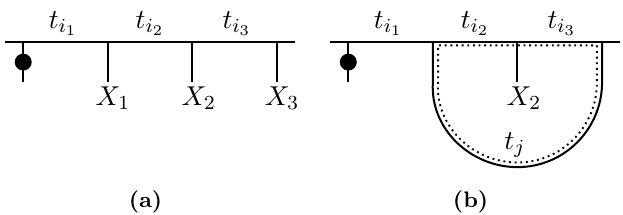
Figure 21. To prove eq. (5.3) inductively for diagrams belonging to a certain class, we can show that the measures [d m 0 ] n +2 and [d m 0 ] n for the diagrams in (cid:12)gure 21a and (cid:12)gure 21b have the ‘ ‘ (cid:0) 1 desired ratio.